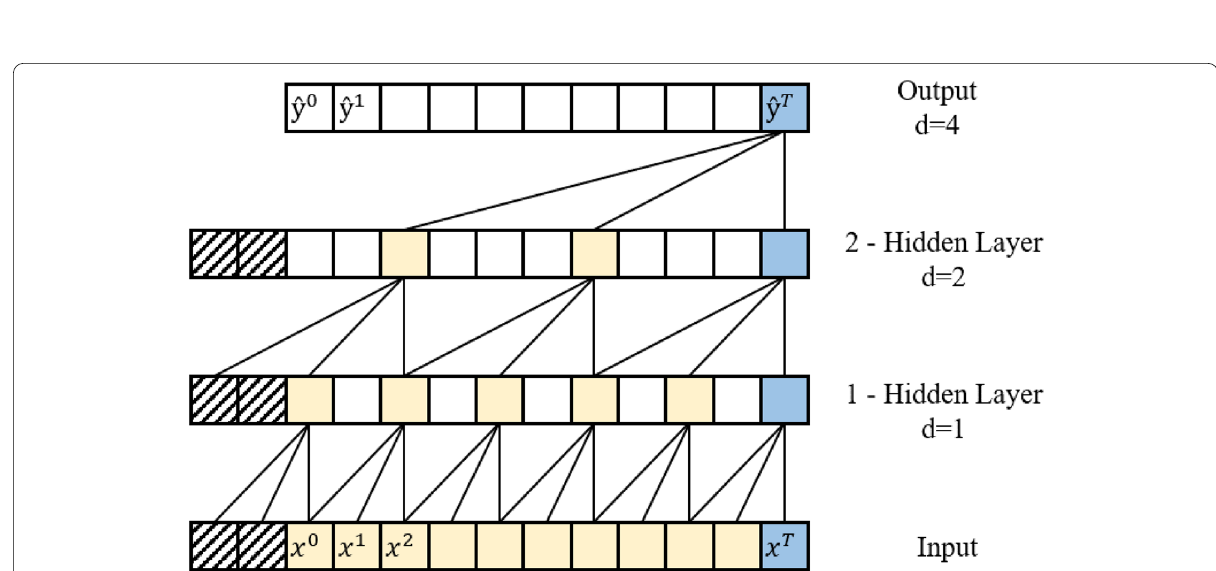
Fig. 7 Diagram illustrating the GRU architecture. The reset and update gate are hidden layers with sigmoid activation function, connections are pair-wise addition and multiplication operators, respectively. At the same time, the || connections are vector concatenation operators